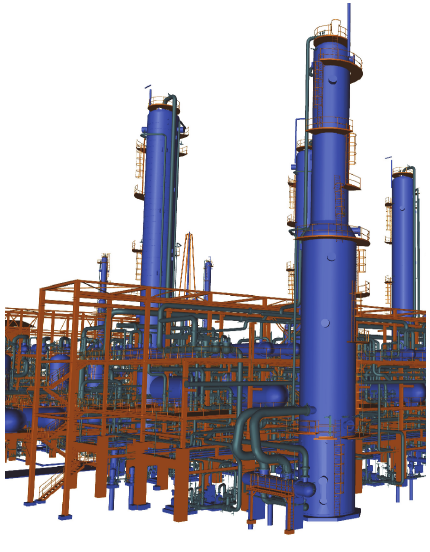
Fig. 7. Abadan Oil Refinery Co Phase 3 (3D